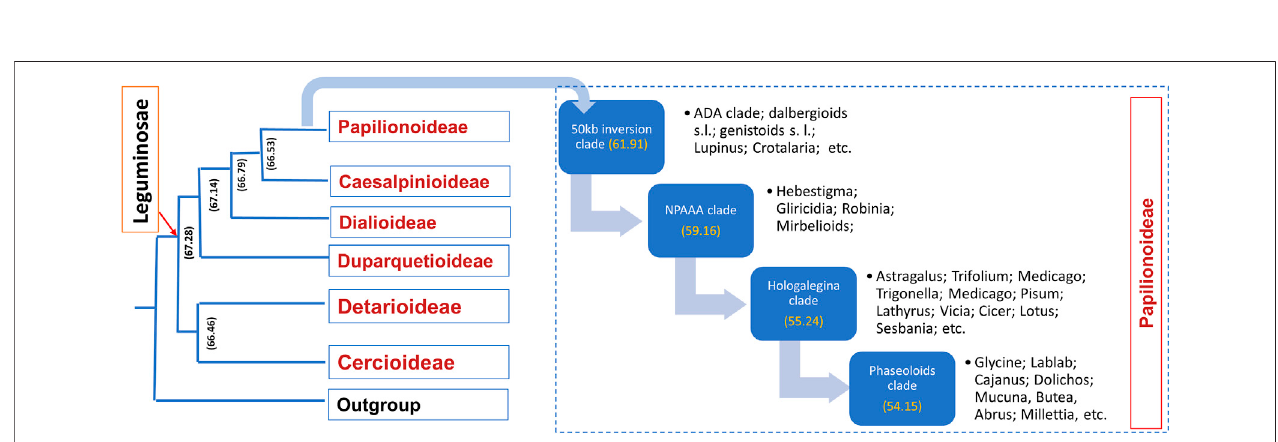
FIGURE 2 | Time divergence of major legume clades. Values inside the brackets are the estimated time of divergence based on phylogenomic studies (source: Zhao et al., 2021).